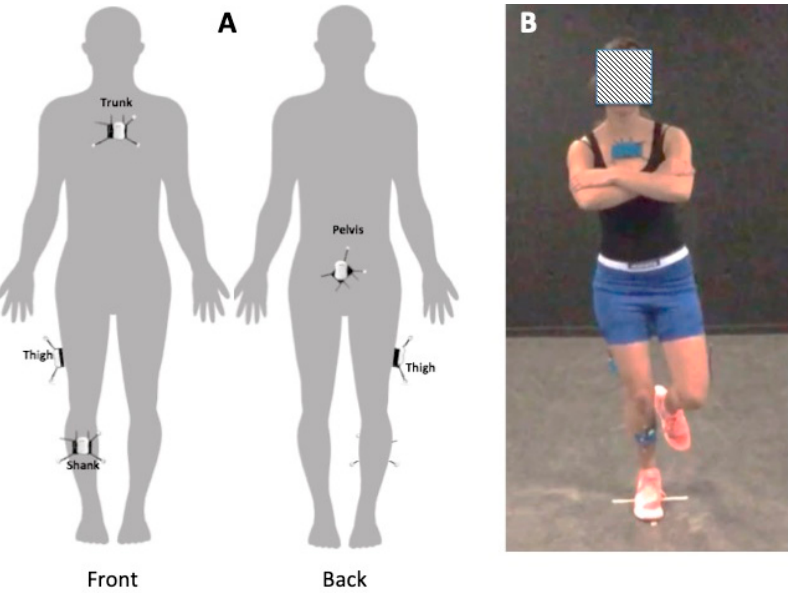
Figure 1. ( A ): The ventral view (left) and dorsal view (right) show the cluster marker and sensor positions on the sternal manubrium, the sacrum, halfway on the iliotibial tract and halfway on the tibia. ( B ): The single leg testing position with markers and sensors attached.